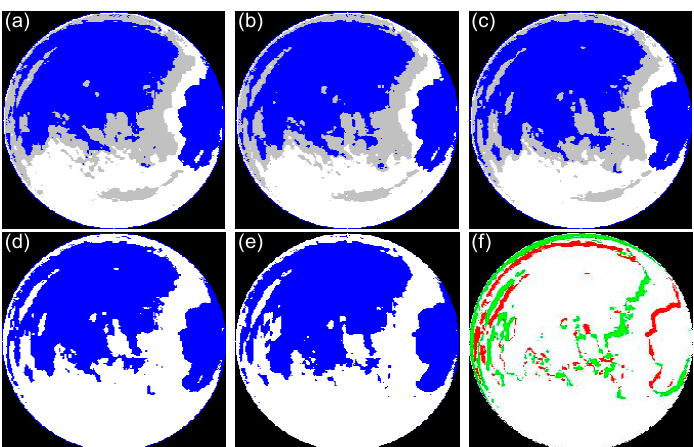
Figure 8. Cloud map forecast and matching error: the forecast cloud map at T + t ( c ) is produced by advecting the cloud map at time T ( b ) in the direction of the motion vector computed from ( a ) ( T − 1) and ( b ) ( T ). To determine the forecast error ( f ), the future binary cloud map at time T + t ( e ) is compared to the forecast binary cloud map ( d ). Red and green colors in ( f ) show forecast errors (red: pixel forecast cloudy but actually clear; green: pixel forecast clear but actually cloudy) and white indicates accurate